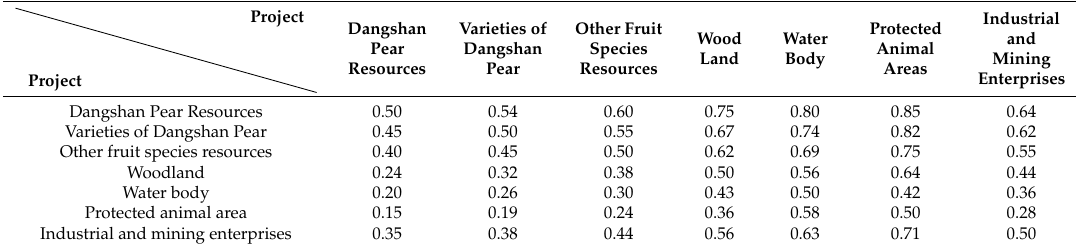
Table 6. Results of the survey of farmers’ roles.